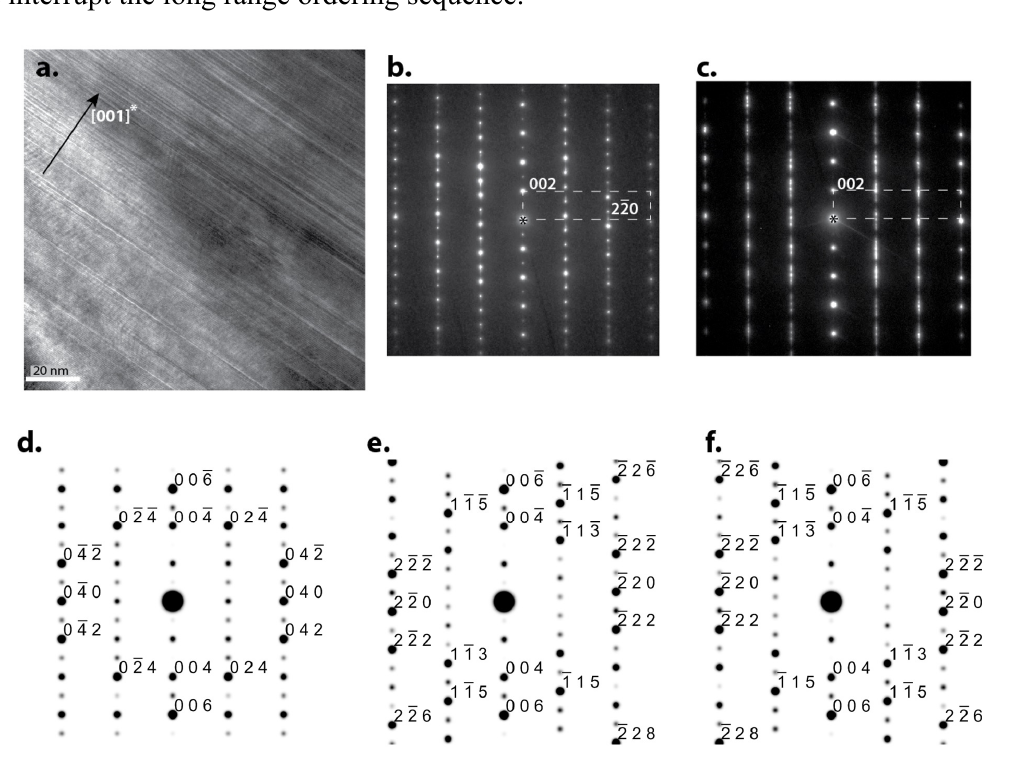
Figure 6. Bright field TEM micrograph of the Zr 2 Ni 7 phase showing parallel planar defects ( a ) and corresponding SAED patterns ( b , c ) showing that the defects’ plane is (001) of the Zr 2 Ni 7 phase with the simulated diffraction patterns along [100] ( d ), [110] ( e ) and [ 110 ] ( f )